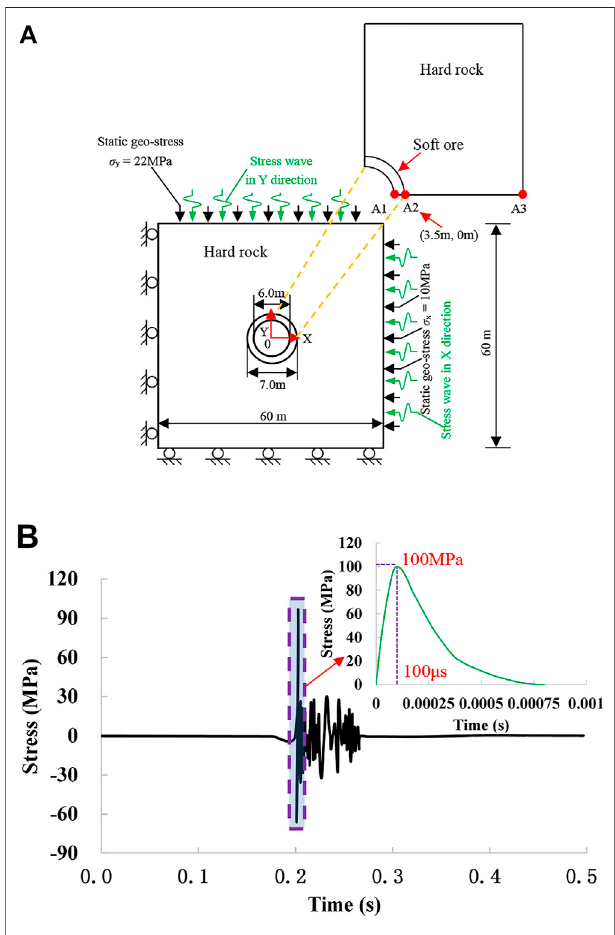
FIGURE 7 | (A) Model setup for numerical simulation of rock under rheology with dynamic disturbance; (B) Waveforms used in numerical simulation of the surrounding rheological rockmass of a shaft.